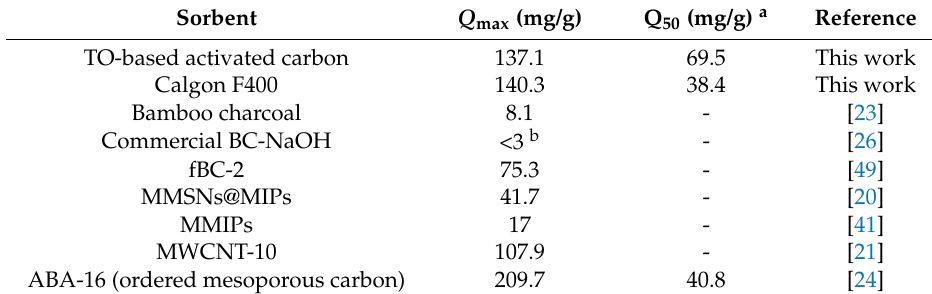
Table 8. CAP adsorption capacities of AC and other sorbents reported in the